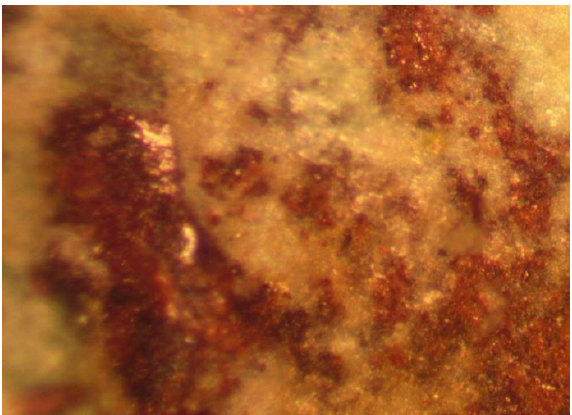
Figure A5. Metal Polymer photomicrographs. Dead-end pores filled with halite (white) in a desali- nation pellet containing functionalized m-Fe 0 :Fe(a,b,c)@C 0 polymers (red brown). Reflected Light. Field of view = 0.5 mm.